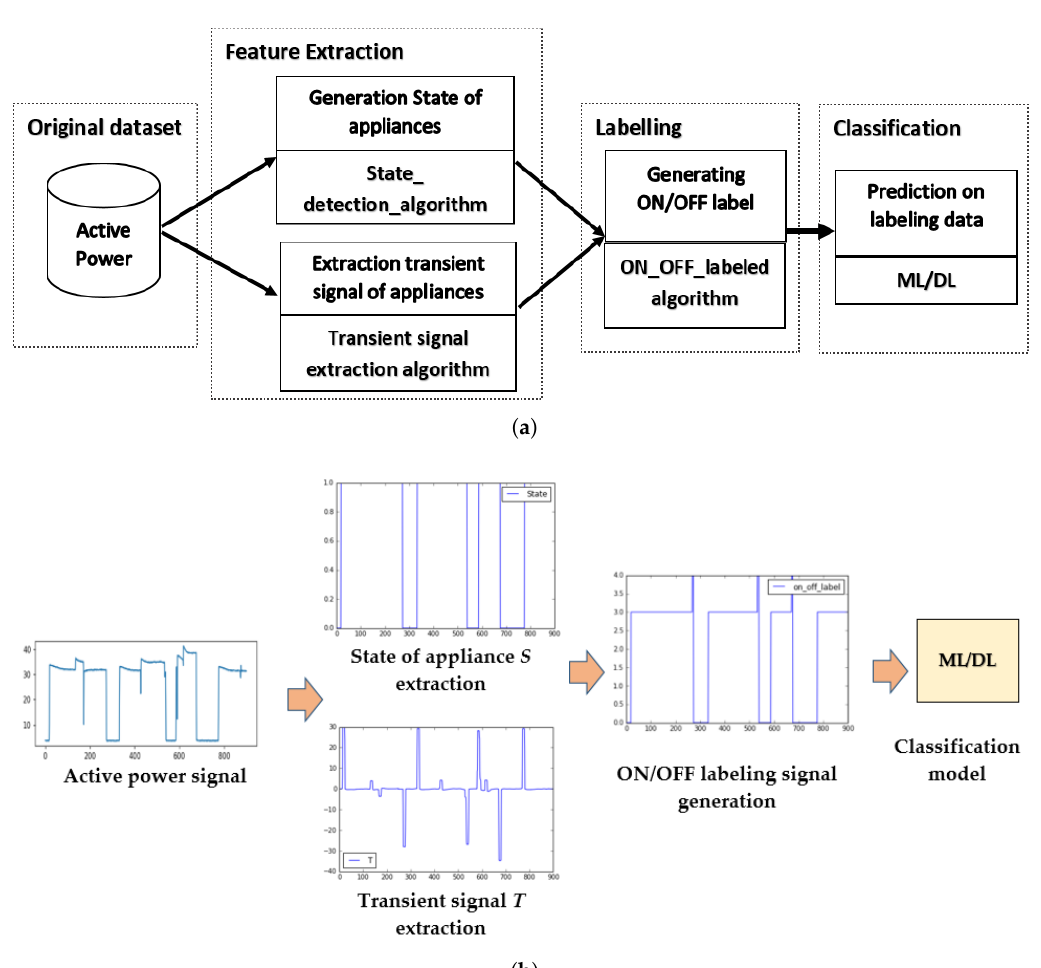
Figure 7. The proposed technique for transient signal extraction and recognition. ( a ) The proposed concept; ( b ) The illustration of the proposed